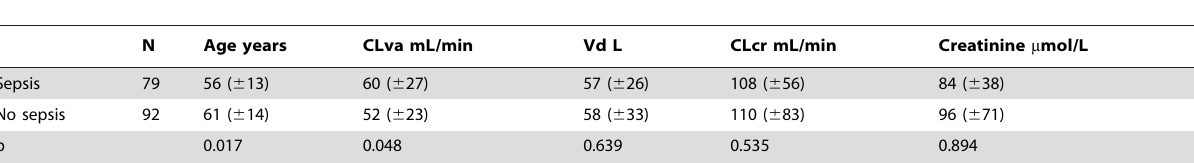
Table 2. Mean ( 6 SD) for Age, CLcr, CLva, Vd, Creatinine for patients with sepsis and without sepsis.